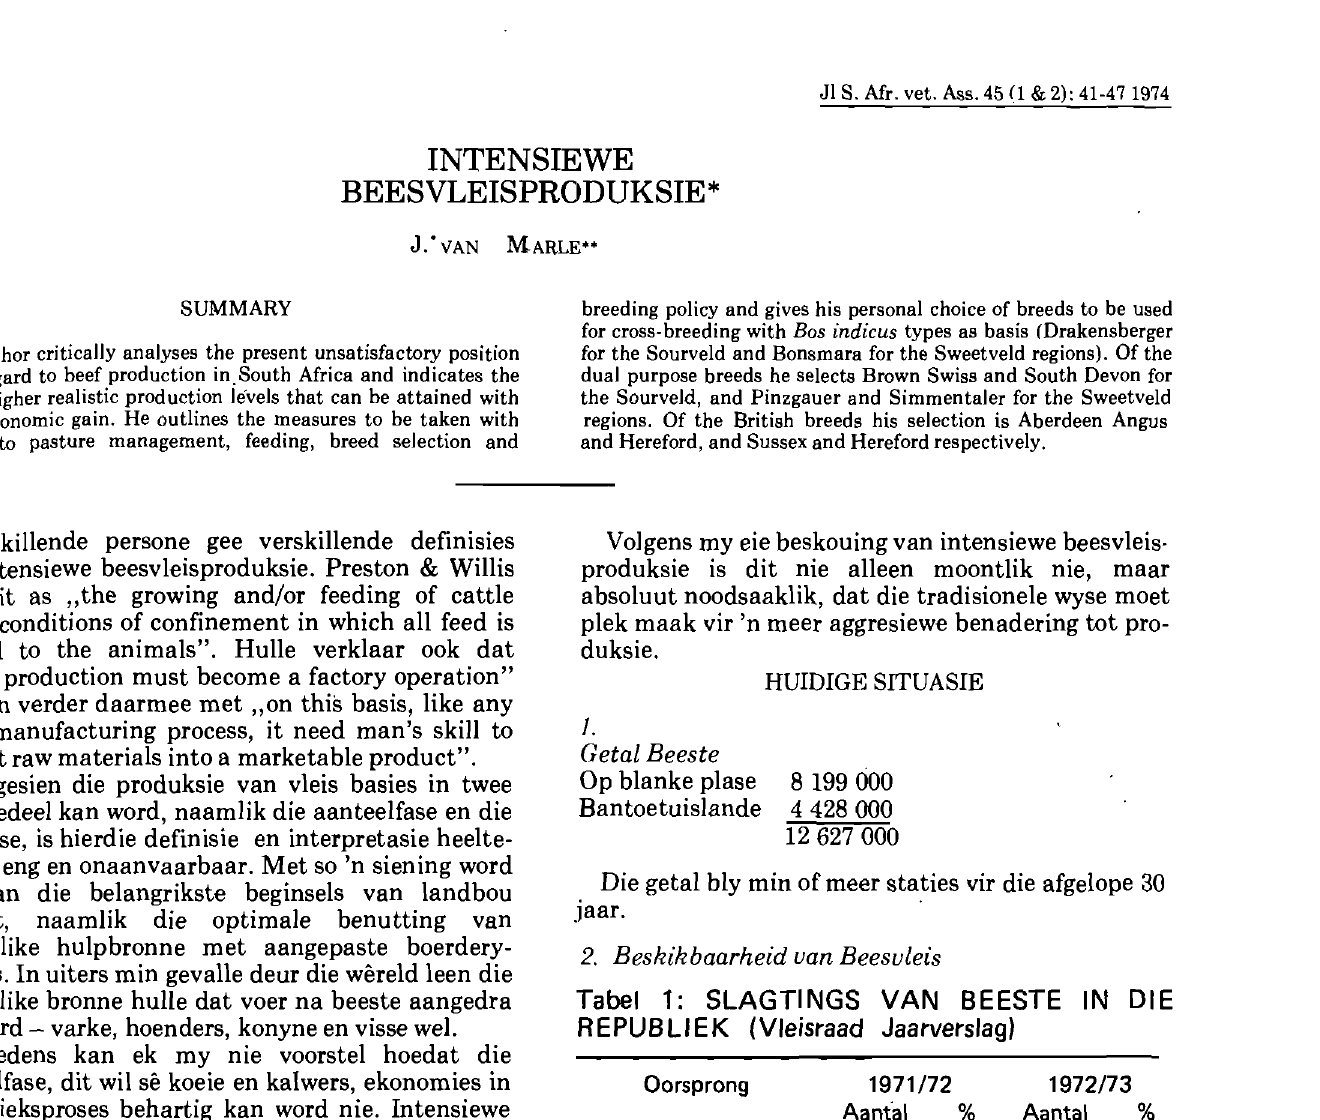
Tabel 1: SLAGTINGS VAN BEESTE IN DIE REPUBLIEK (Vleisraad